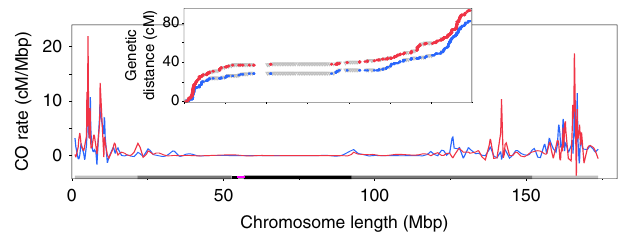
Fig. 1 CO landscape of chromosome 7. See Supplementary Fig. 3 for other chromosomes. Blue = male COs, red = female COs. Colors on the X -axis indicate chromosome regions: purple = functional centromeres ( = CENH3- binding regions 59 ), black = centromere repeats, gray = pericentromeric regions, light gray = distal regions. Insets are cumulative genetic distances across entire chromosomes. Gray triangles in insets are supplemental SNPs added, where needed, to create 1 Mbp intervals. Figures were generated